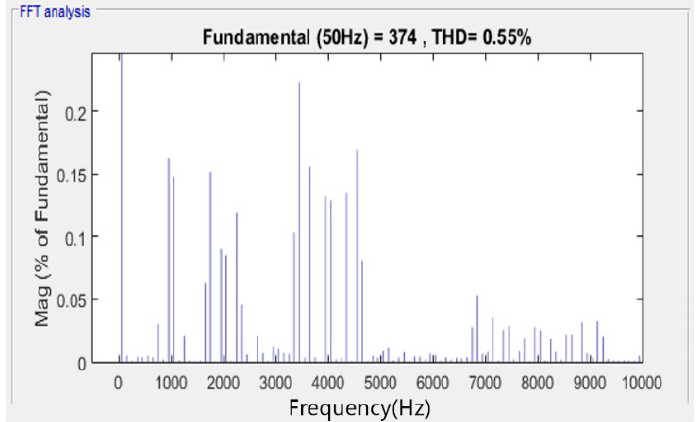
Figure 20. Three-phase four H-bridge CHB current THD for PS PWM and best switching of non-equal sources.